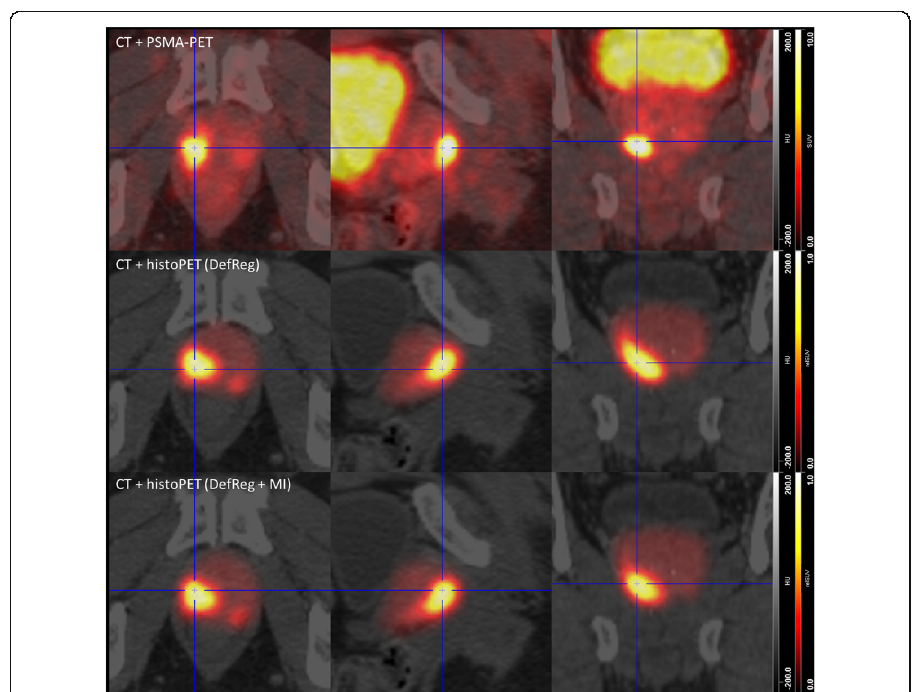
Fig. 5 Visual comparison of PSMA-PET/CT and histoPET models according to DefReg and DefRegMI coregistration. The deformation of the 3D histoPET by the deformable registration algorithm is clearly visible. Results showed that DefReg is more sensitive to uncertainties in contours of the prostate on in vivo and ex vivo CT than the pure manual ManReg is. However, pattern agreement between PSMA-PET and histoPET with R 2 values from 50.8 to 62.2% without and with MI coregistration step were